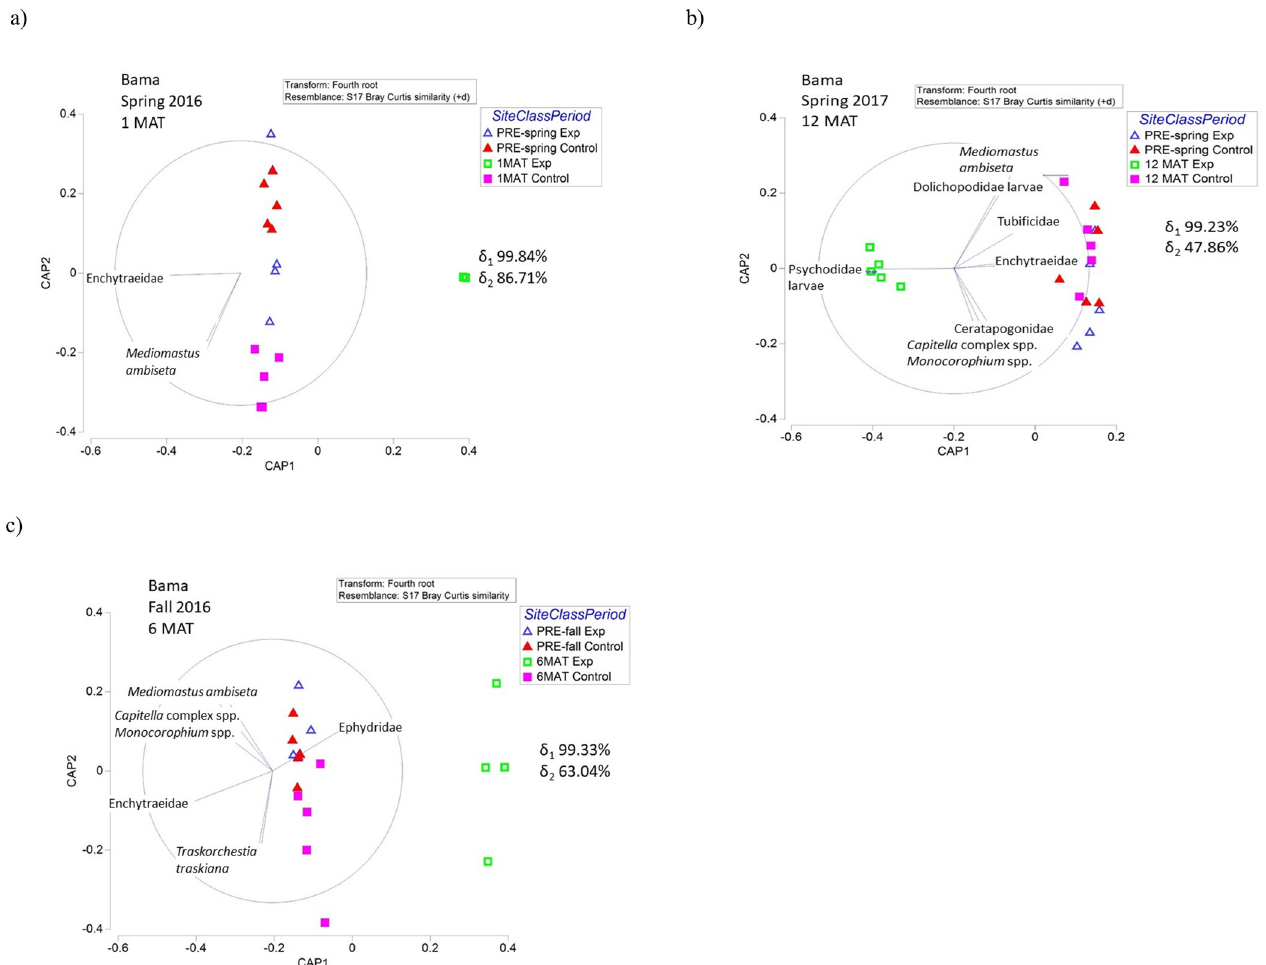
Fig 8. Infaunal invertebrate CAP plots showing the change in community composition of invertebrates for each sampling season (a,b,c) in Bama habitats compared to pre-sediment application data. Canonical correlation values ( δ ) for each axis are reported to show strength of the association between the multivariate data cloud and the hypothesized group differences. Habitats are abbreviated as follows: Spartina foliosa -dominated (Spfo), Batis maritima- dominated (Bama), and ponds or standing water (Pond). Exp is the experimental sediment application area/site. MAT is months after treatment.